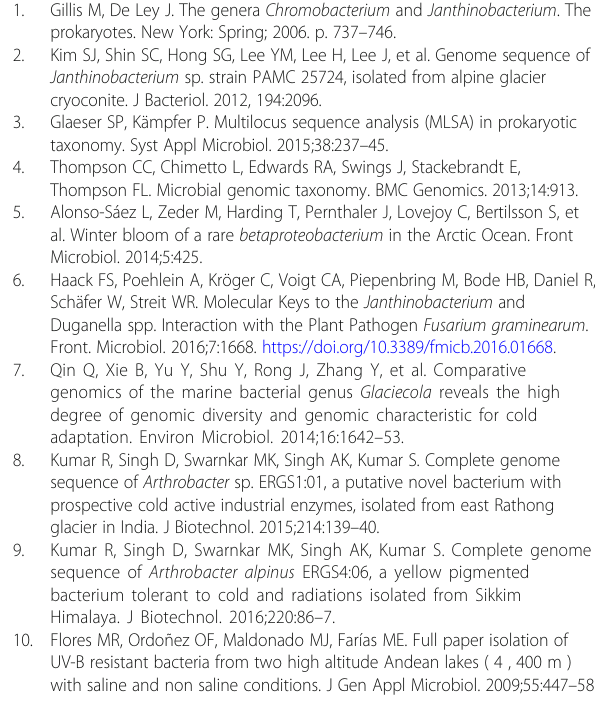
Additional file 1: Figure S1. Multilocus sequence analysis (MLSA) clustering based phylogenetic tree of six concatenated housekeeping genes as derived from the whole genome sequence from the strains of Janthinobacterium. The tree was constructed using the neighbor-joining method based on the JTT matrix-based model using MEGA7 .Bootstrap values over 50% (1000 replications) were shown at each node. All positions containing gaps and missing data were eliminated. The clustering patterns are in agreement with the data generated by the maximum likelihood method. (PDF 238 kb) Additional file 2: Table S1. Whole genome sequence-based in silico comparison of strain ERGS5:01 and other related Janthinobacterium strains in database for DDH and ANI. (DOCX 17 kb) Additional file 3: Figure S2. Certificate of deposition of strainERGS5:01 at Microbial Culture Collection (MCC) at National Centre for Cell Science, Pune, India. (PDF 377 kb) Additional file 4: Table S2. Genes predicted to encode industrially important enzymes in the genome of J. lividum ERGS5:01. (DOCX 14 kb) Additional file 5: Figure S3. Pan genome analysis of genus Janthinobacterium . The pan-genome profile plot displaying the total and the core gene families for each genome with a curve fit exponent of 0.43. [Number of unique genes observed for strains are displayed in brackets; 1. J. lividum ERGS5:01 (236); 2. J. sp. 551a (0); 3. J. agaricidamnosum DSM 9628 (1412); 4. J. sp. CG23_2 (2860); 5 . J. sp. CG3(1038); 6. J. sp. HH01 (1764) 7. J. sp. KBS0711 (66) 8. J. lividum H-24 (217); 9. J. lividum NFR18 (86); 10. J. sp. Marseille (1625); 11. J. lividum MTR (197) 12. J. sp. OK676 (171); 13. J.